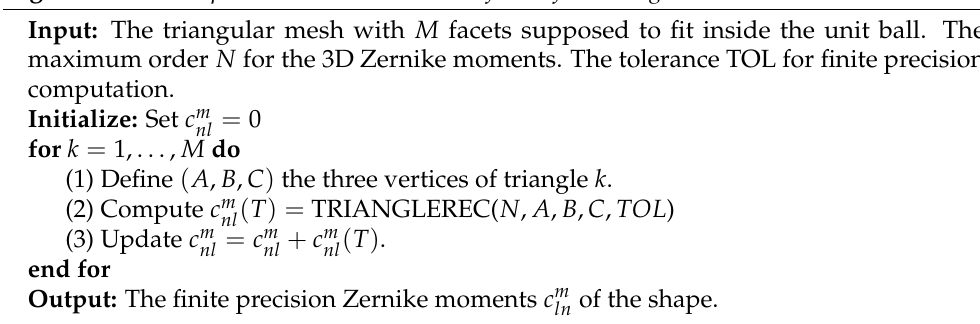
Algorithm 3 Finite precision Zernike moments for surface triangular meshes